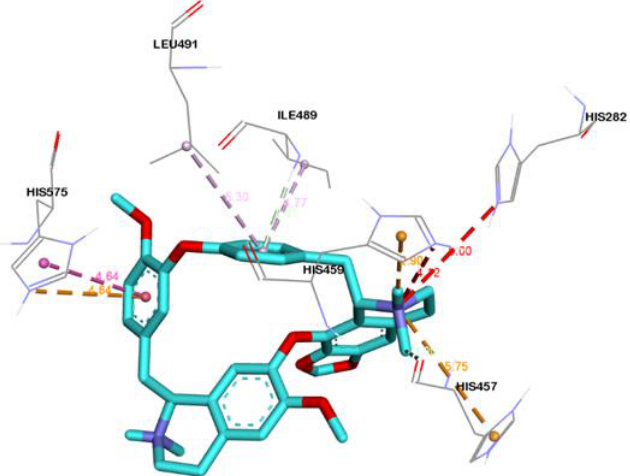
Figure 5. Three-dimensional interaction diagram showing the molecular interactions of Cepharanthine with binding pocket residues (grey). Molecular interactions include carbon hydrogen bond (pale green), unfavorable positive–positive (red), pi–cation (tangerine), pi–donor hydrogen bond (transparent green), pi – pi T-shaped (rose pink), and alkyl and pi – alkyl (light pink). The docking of Zafirlukast with human ASM revealed that the ligand had a high protein were also recorded. The docked complexes were visualized in Discovery Studio. affinity of − 9.5 kcal/mol. Molecular docking of Zafirlukast with the target protein led to 15 molecular interactions between the ligand and the pocket residues of human ASM. The best fitting of ligand inside the core pocket region of ASM was further evidenced by the conventional hydrogen bond of Zafirlukast with ASN-318, HIS-575, and ILE-489, and pi – alkyl and alkyl interaction with ILE-489 (Figure 6). On ADME analysis, Zafirlukast was found obeying Lipinski’s rule with log p value of 5.5, 2 hydrogen bond donors, 6 hydrogen bond acceptors, topological surface area of 54.4 Å 2 , 2 rotatable bonds and 1 violation i.e., molecular weight greater than 500.